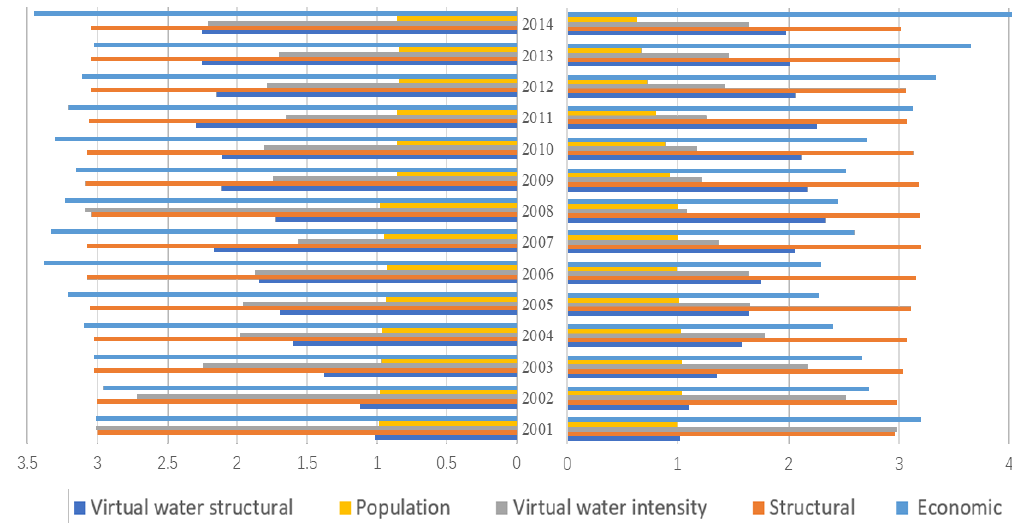
Figure 6. Contribution rates of various drivers to European Union virtual water exports ( right ) and imports ( left ).